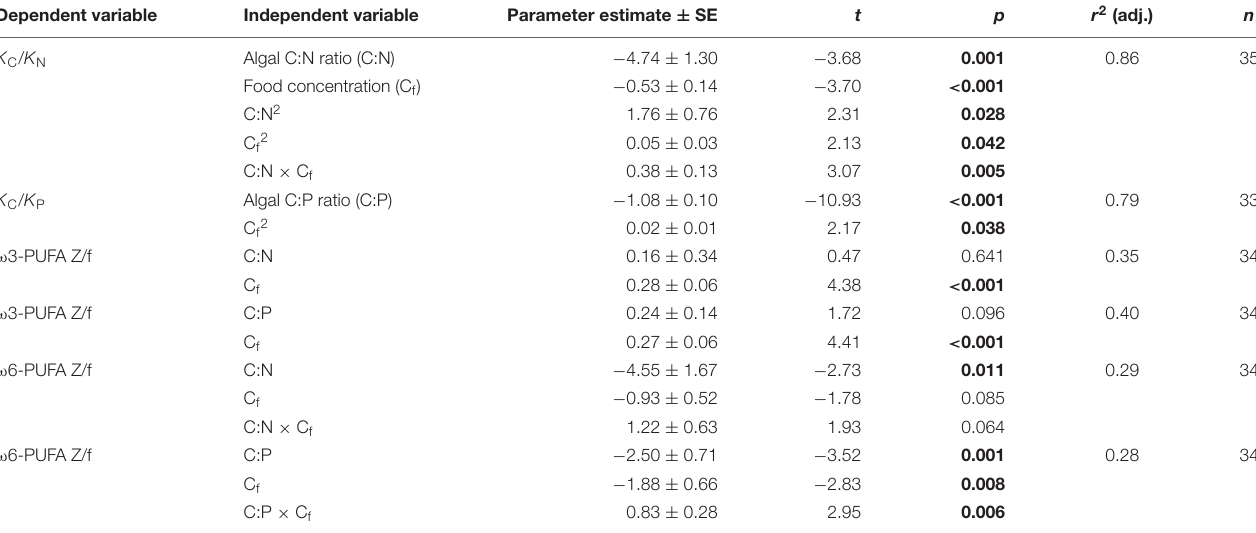
TABLE 3 | Results of multiple regression analyses for the relative gross growth efficiency for carbon and nitrogen ( K C / K N ), the relative gross growth efficiency for carbon and phosphorus ( K C / K P ), the ratio of ω 3-PUFA contents between Acartia tonsa and food ( ω 3-PUFA Z/f), and the ratio of ω 6-PUFA contents between A. tonsa and food ( ω 6-PUFA